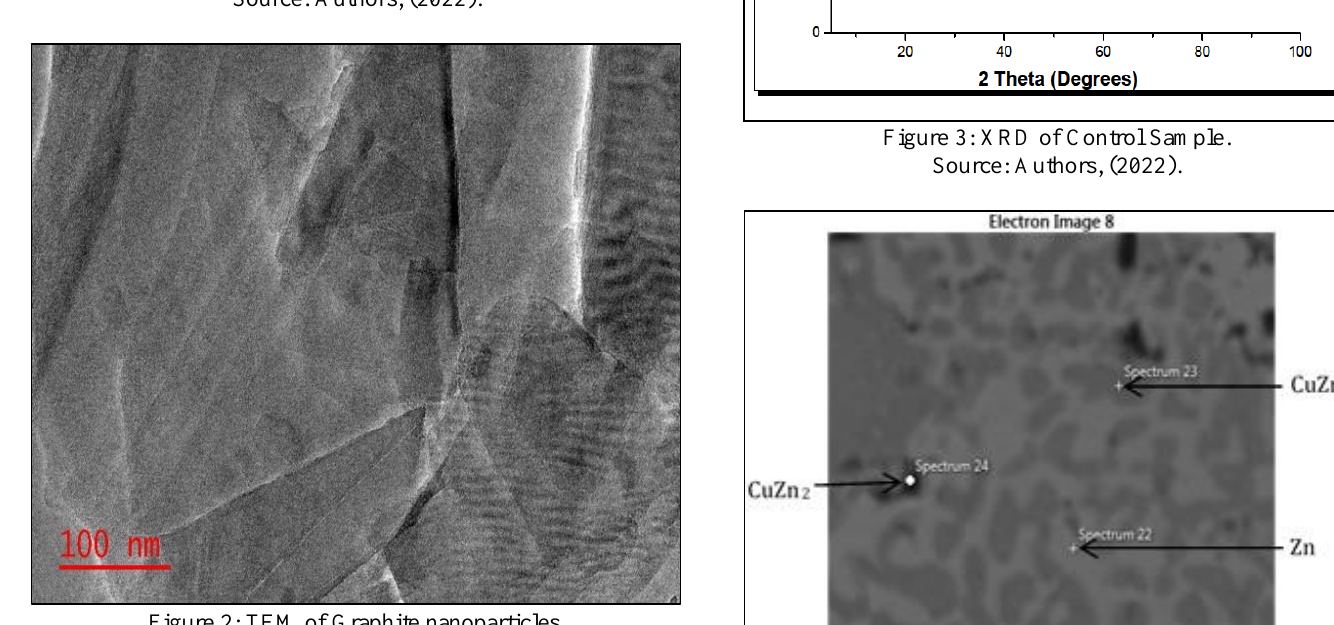
Figure 1: XRD of Graphite nanoparticles.